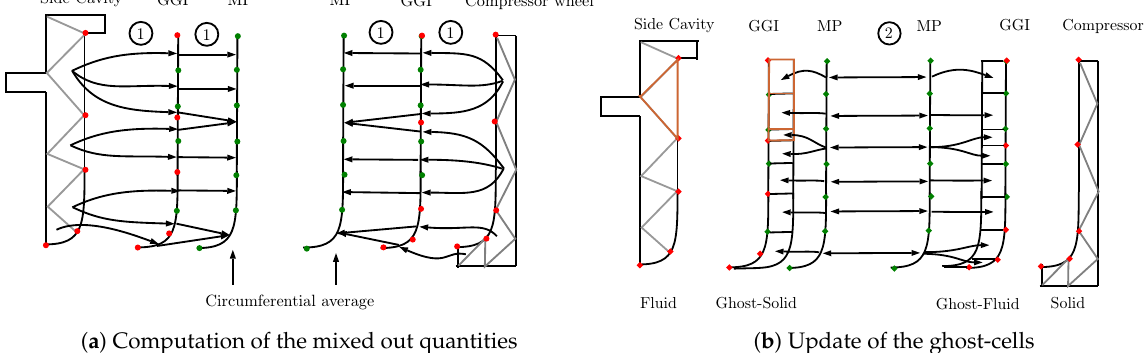
Figure 3. Dual interface strategy for the computation of mixed out